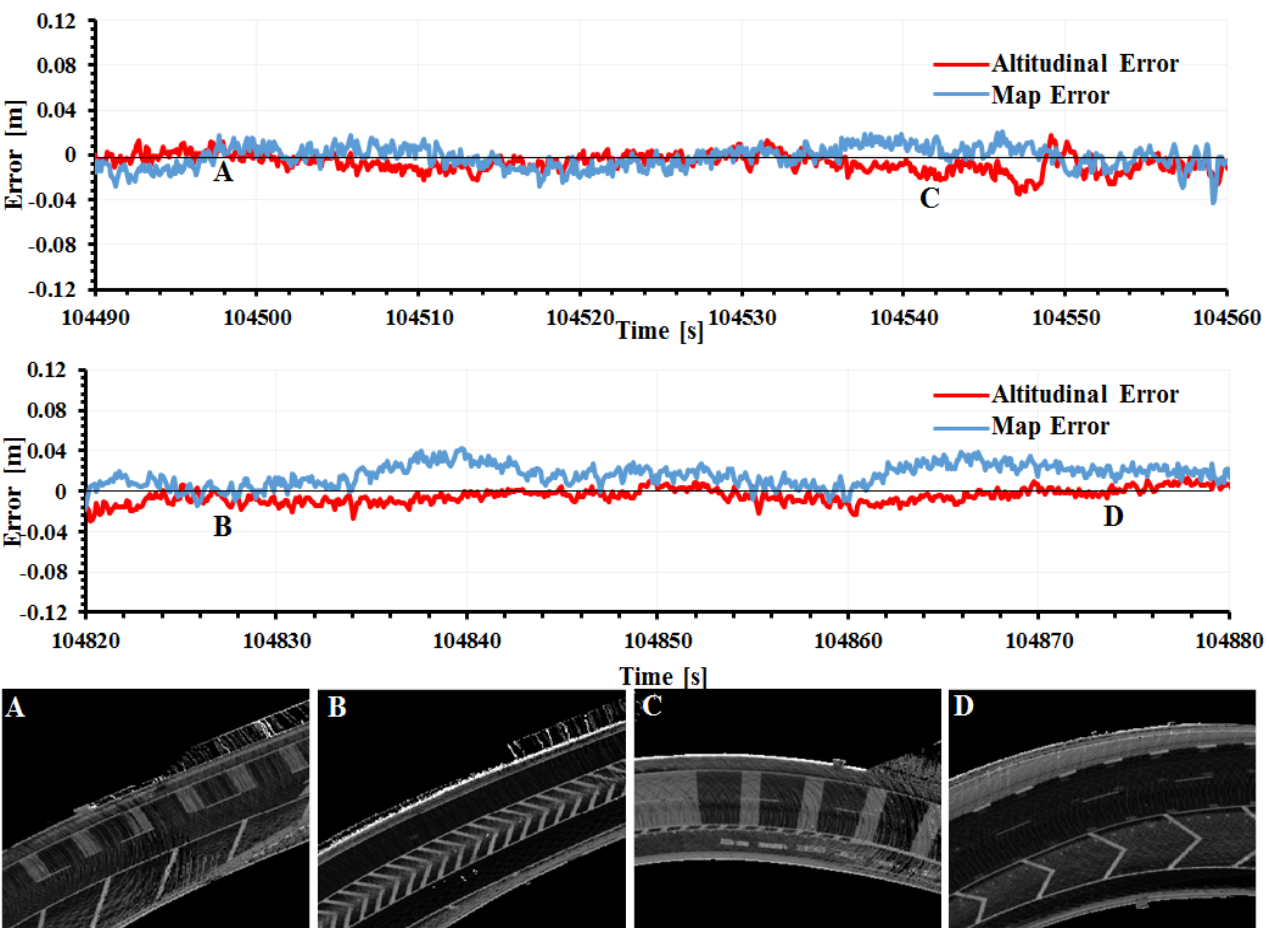
Figure 13. The elevation map error compared to GIR and the altitudinal accuracy in upward and downward trajectories with map images in the common areas ( A – D ) that were retrieved by the proposed localization system based on layered elevation-intensity images. The RMSE errors of the map and altitudinal errors in the upward and downward trajectories are 0.025 m, 0.019 m, 0.029 m and 0.011 m.